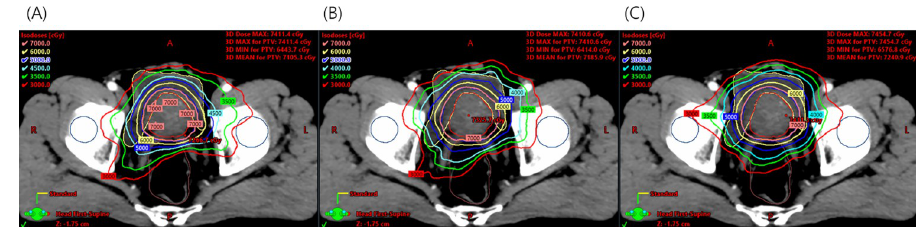
Fig 3. The dose distributions for a representative case that were obtained from (A) MCO, (B) re-optimization, and (C) recalculation.